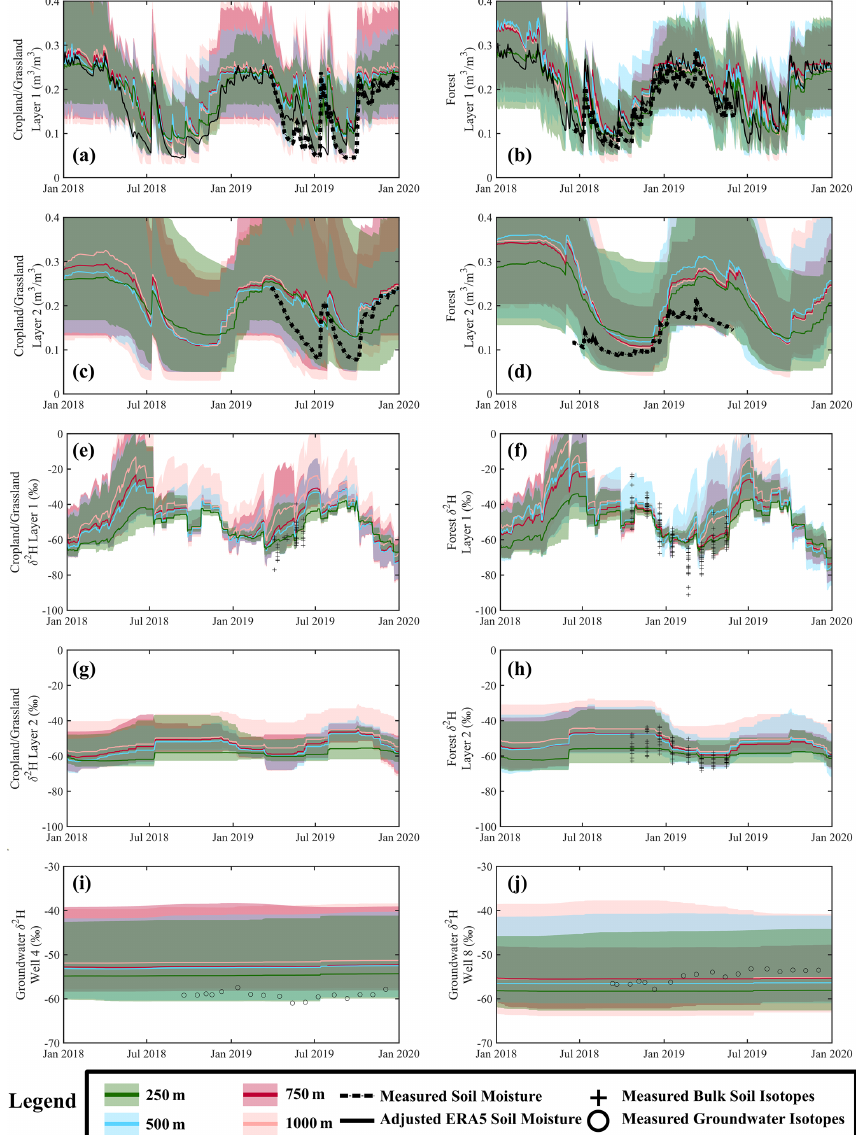
Figure 5. Simulations and measured soil moisture in layers 1 (a, b) and layer 2 (c, d) in the croplands (a, c) and in the forest (b, d) . Also shown are adjusted ERA5 soil moisture estimates at the same locations. Measured and simulated soil isotopes in layer 1 in (d) the forest (e) the cropland, and layer 2 in (g) the forest and (h) the cropland. Simulated and measured groundwater isotopes at (i) groundwater well 4 (GW 4) and (j) groundwater well 8 (GW